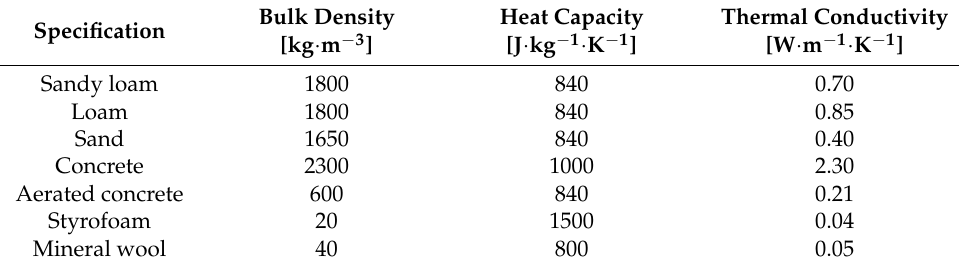
Table 1. Physical parameters of the soil and construction materials used in the calculations.